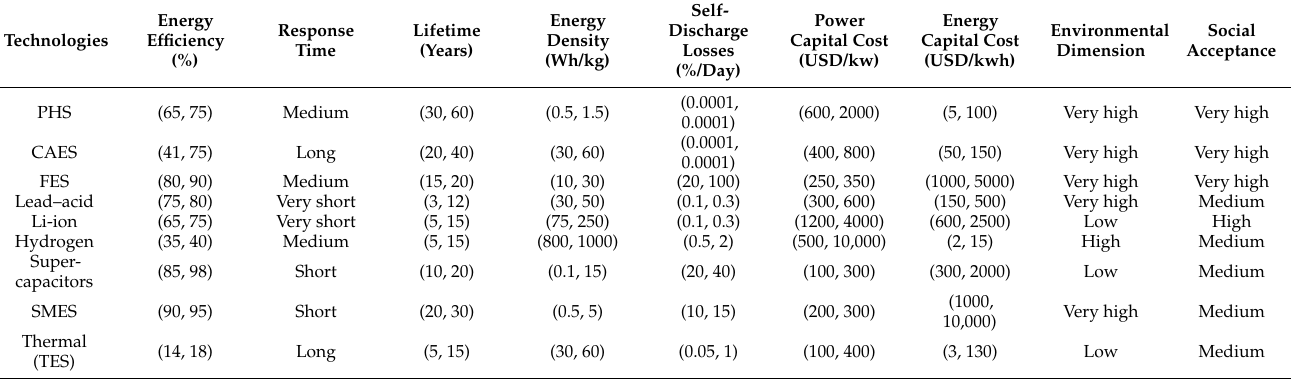
Table A9. Decision basic data of Expert 6.